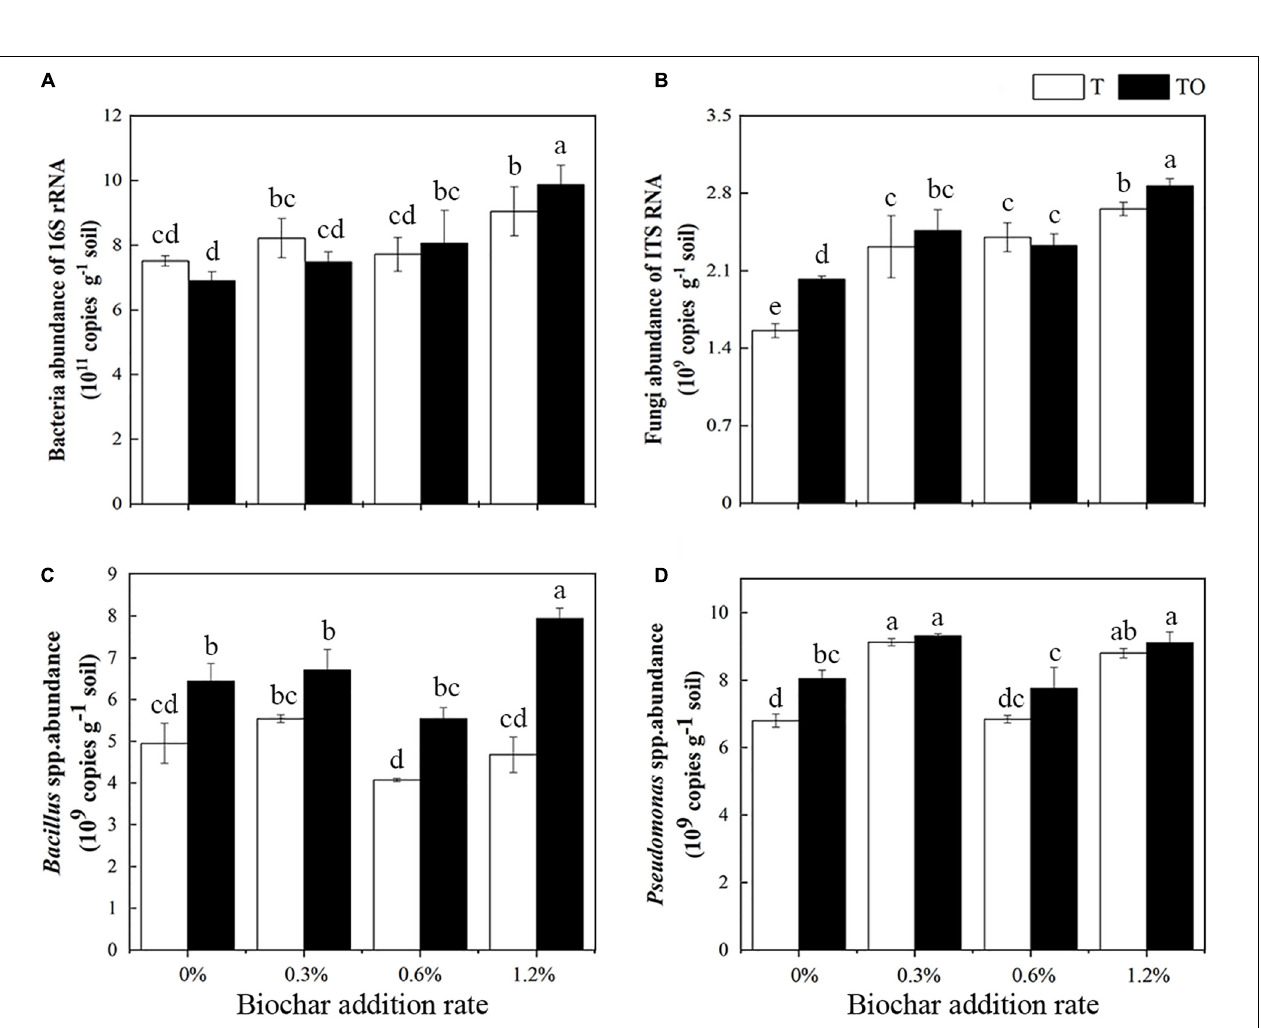
FIGURE 3 | Effects of different concentrations of biochar amendment and intercropping on the abundances of total bacteria (A) , fungi (B) , Bacillus spp. (C) , and Pseudomonas spp. (D) in tomato rhizosphere soil after 30 days pot experiment in 2019. T and TO indicate tomato monoculture and intercropped with potato–onion, respectively. 0, 0.3, 0.6, and 1.2% indicate the biochar rates. Different letters indicate the statistically significant differences among treatments ( P < 0.05).